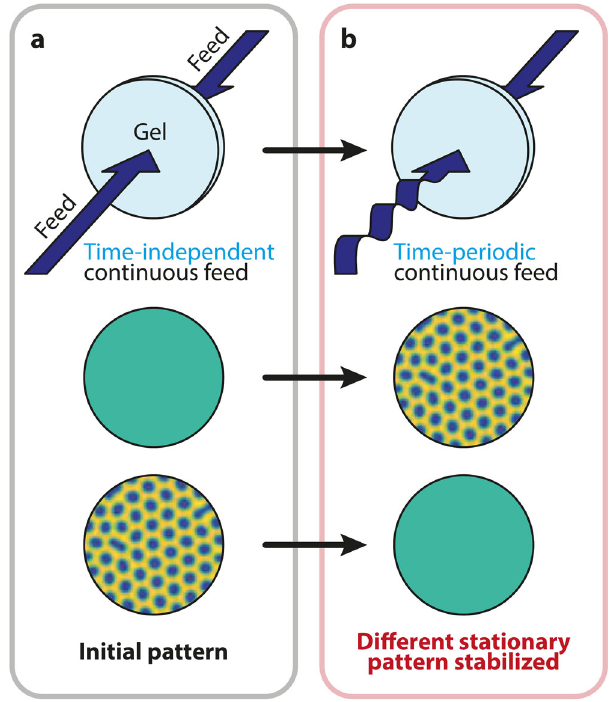
Fig. 1 Concept of controlling Turing patterns by periodic forcing. Different initial patterns can be stabilized at constant feed concentrations ( a ). During the continuous periodic forcing of the input feed concentration of one reactant drastically different pattern forms in the system ( b